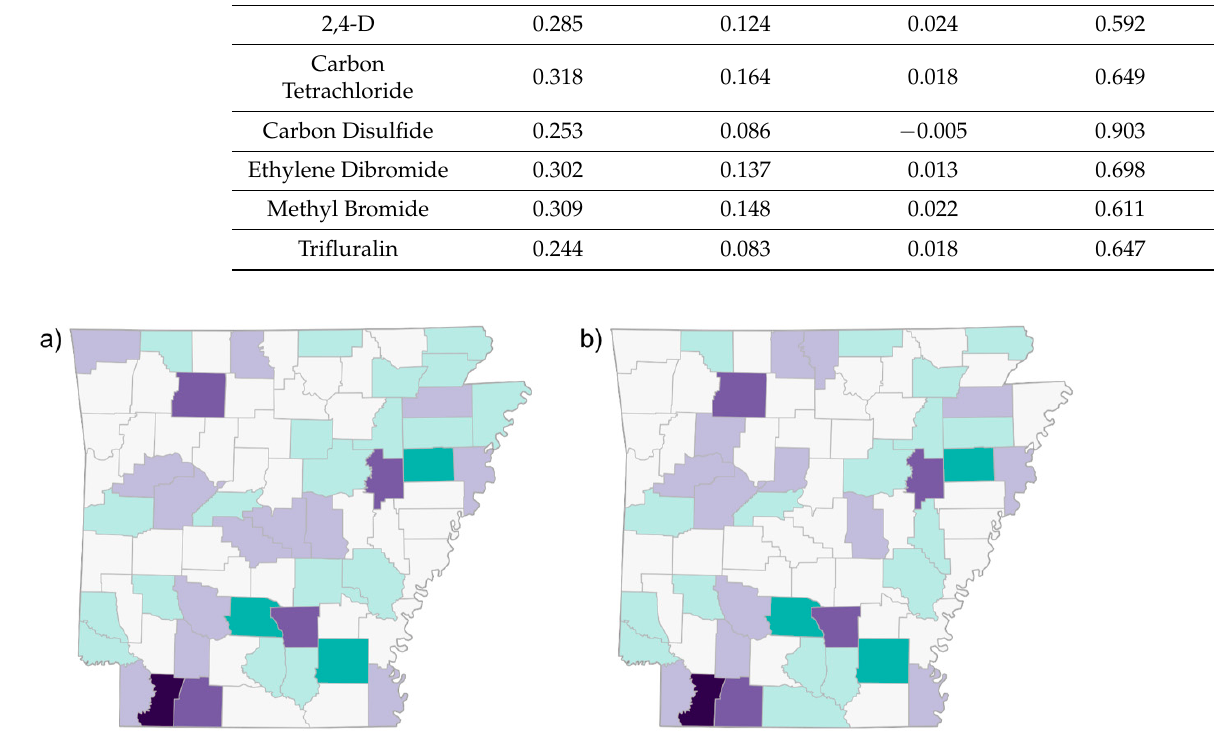
Figure 5. Distribution of residuals from geographically weighted regressions of selected chemicals, demographic variables, and colorectal cancer incidence: ( a ) 2,4-D, salts and esters; ( b ) carbon tetra- chloride; ( c ) carbon disulfide; ( d ) ethylene dibromide; ( e ) methyl bromide; and ( f ) trifluralin. 4. Discussion Each of the six selected pesticide chemicals exhibited a nonrandom spatial distribu- tion in AR, as evidenced in the spatial patterns of the OLS residuals (Figure 4). These dis- tributions violate the assumption of independence of observations, which partially